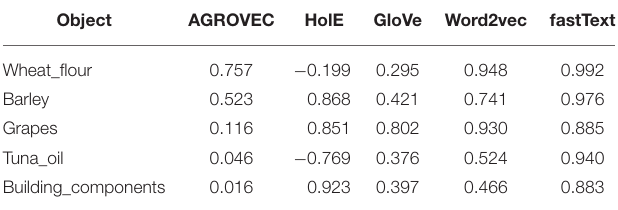
TABLE 1 | An example on how each model ranks the objects when the subject is “wheat” AGROVEC ranks the semantic similarity scores accurately from closest to furthest from the subject.